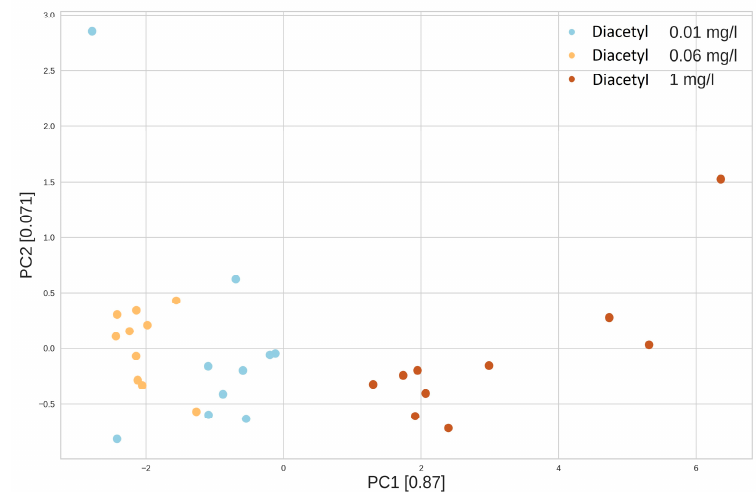
Figure 3. PCA on the 5% hydroalcoholic solution. Blue: 0.01 mg/L; yellow: 0.06 mg/L; brown: 1 mg/L.